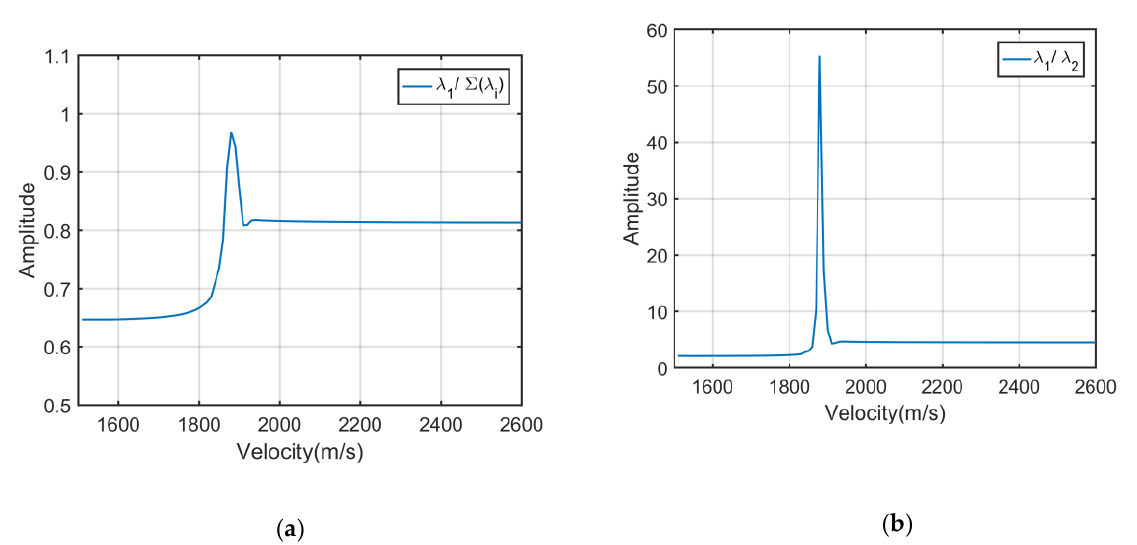
Figure 2. The weighting factors β 1 and β 2 varying with the scanning velocity. ( a ) Represents the Figure 2. The weighting factors 1  and 2  varying with the scanning velocity. ( a ) Represents Figure 2. The weighting factors 1  and 2  varying with the scanning velocity. ( a ) Represents weighting factor β 1 varying with the scanning velocity and ( b ) represents the weighting factor β 2 the weighting factor 1  varying with the scanning velocity and ( b ) represents the weighting factor the weighting factor 1  varying with the scanning velocity and ( b ) represents the weighting factor  . 2  . 2  and  to construct a new weighting function 1 2  and  to construct a new weighting function Then, we combined factors 1 2 ) w it  . The new weighting function is defined as i